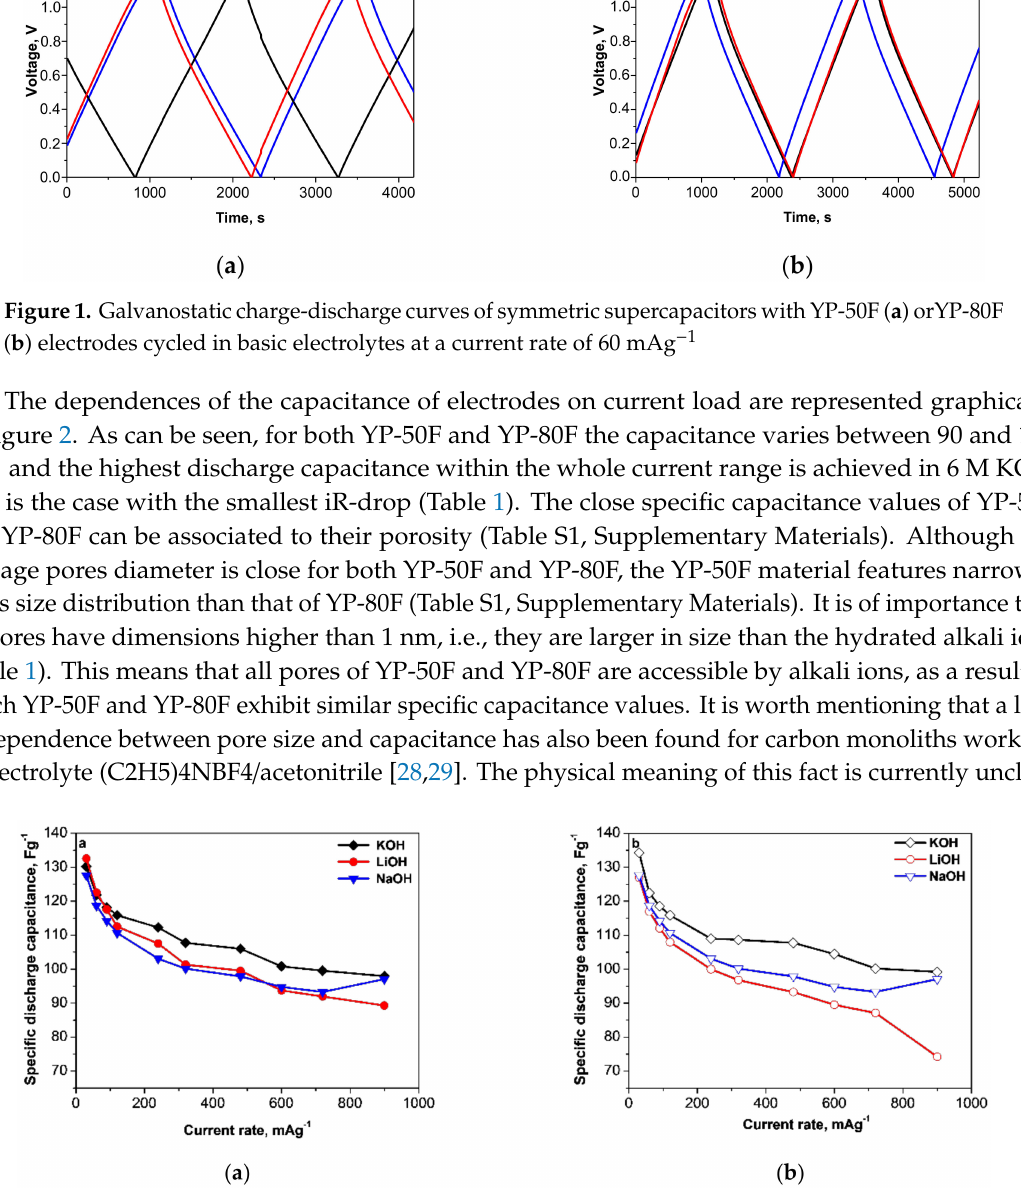
Figure 2. Discharge capacitance depending on the current load for supercapacitors with YP-50F ( a ) or YP-80F ( b ) electrodes in di ff erent